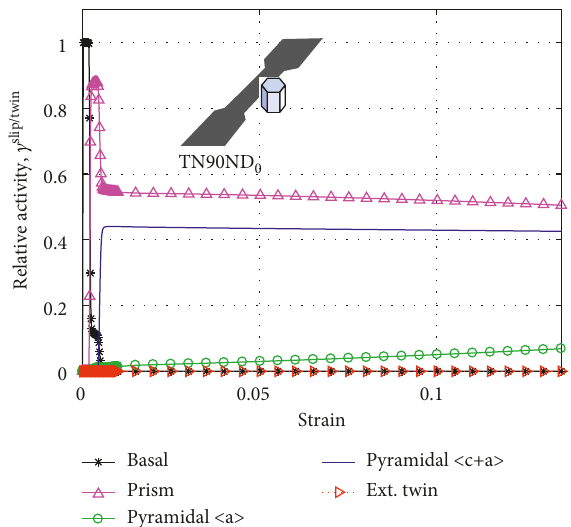
Figure 11: Relative slip and twin activities predicted by crystal plasticity simulation during uniaxial tension of pure Mg with the basal plane parallel to the tensile axis, TA90ND 0